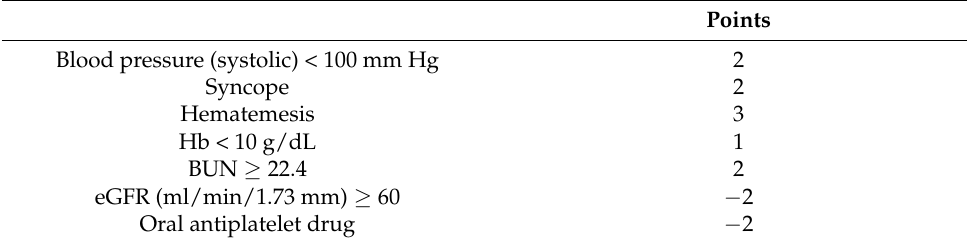
Table 9. Iino score